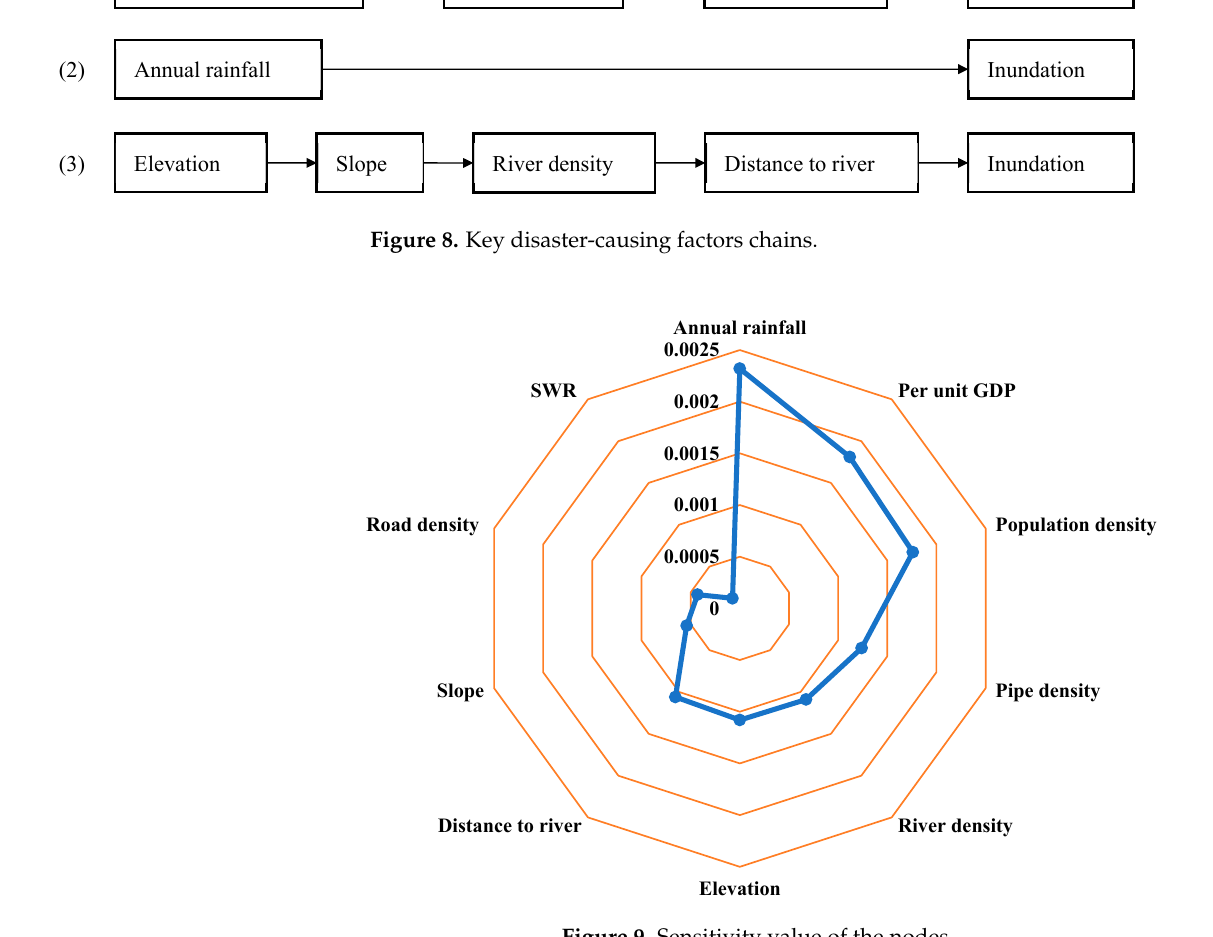
Figure 9. Sensitivity value of the nodes.